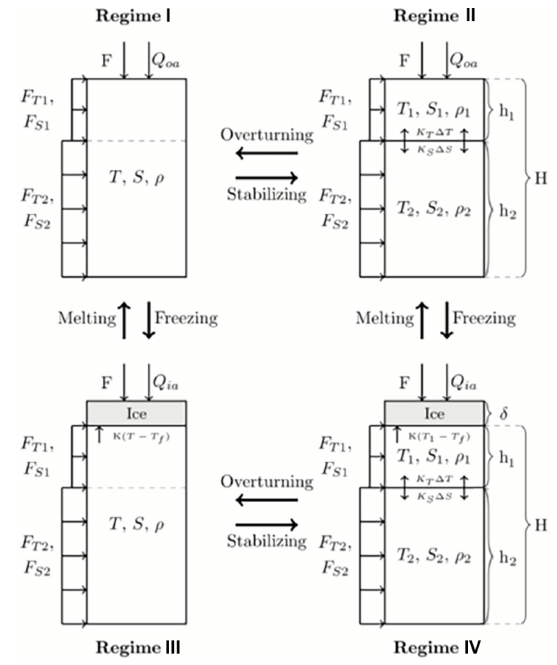
Figure 1. A schematic representation of the different regimes of the extension of the model used in Martinson et al. (1981). The parameters displayed in the figure are explained in the text. The directions and size of the arrows are not necessarily a representation of the actual direction and magnitude of the fluxes. The actual size and direction are dependent on the state of the model. Positive fluxes represent fluxes entering the water column. Regime transitions are shown by bold